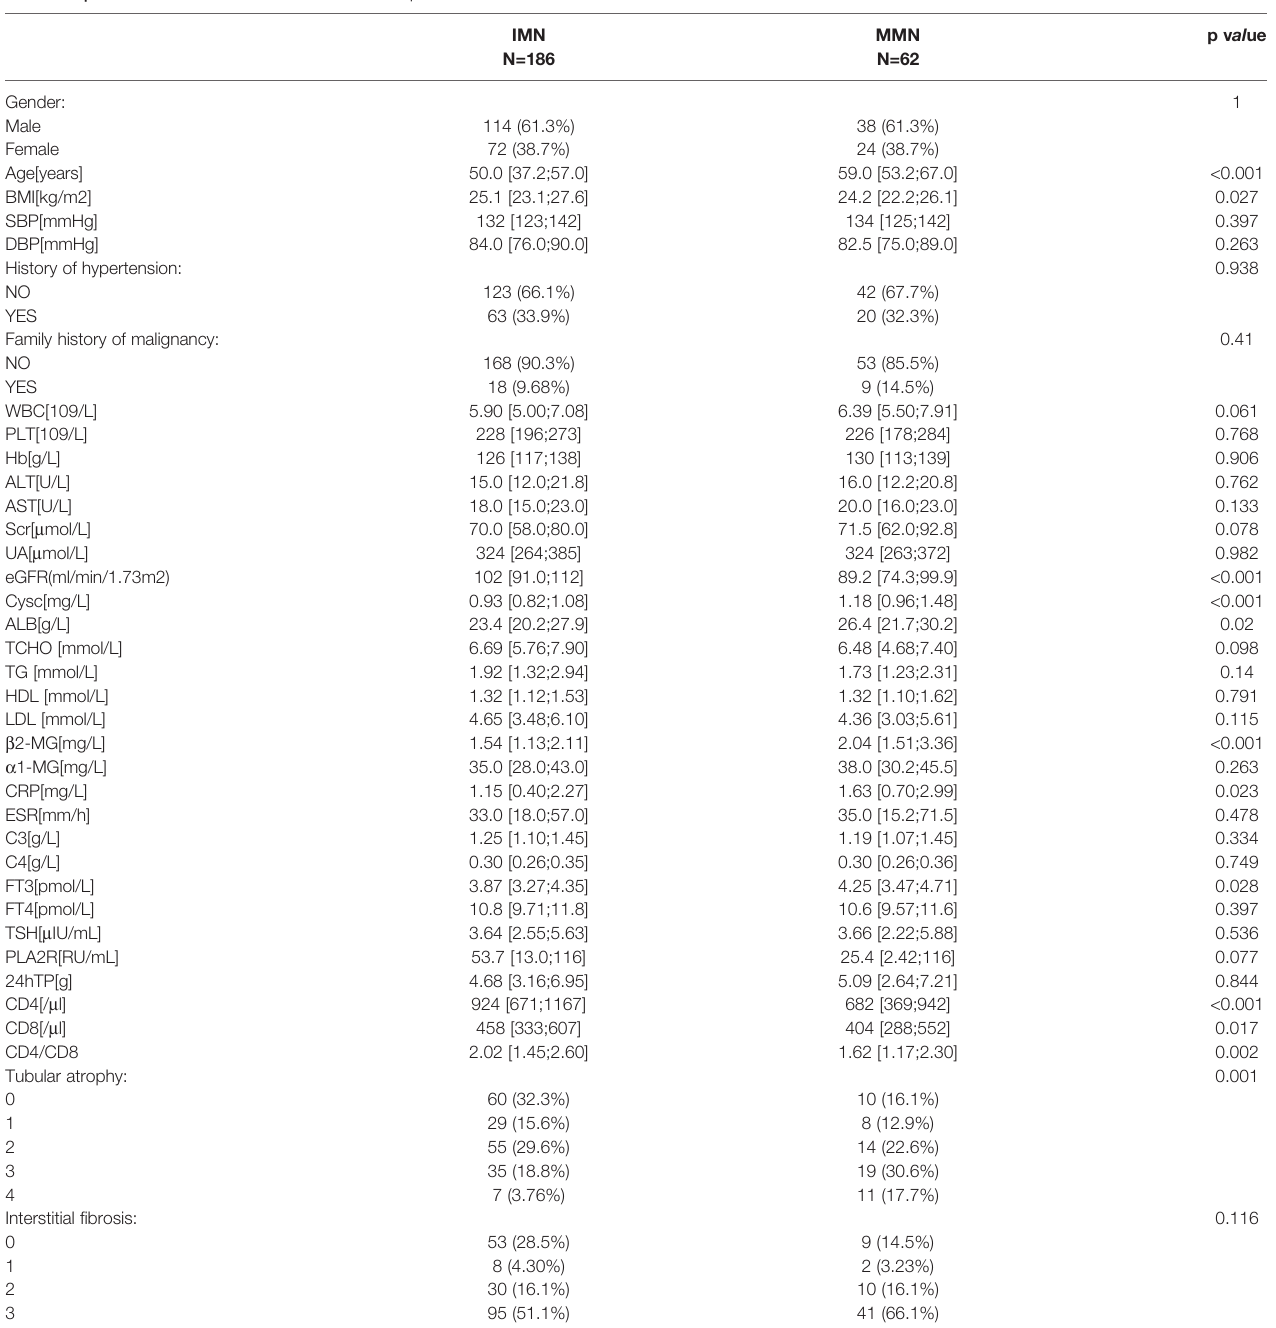
TABLE 2 | Baseline characteristics of IMN and MMN patients included in the model.